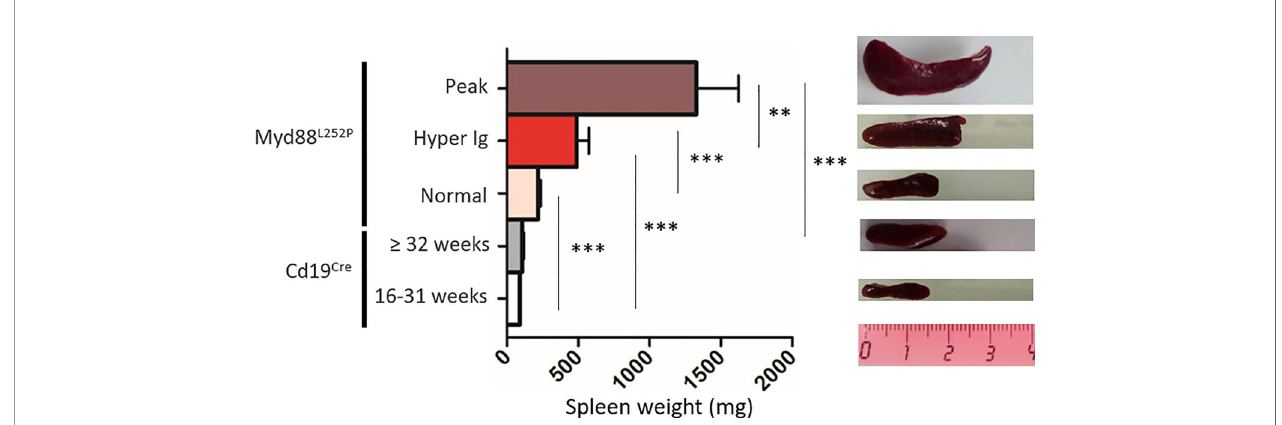
FIGURE 4 | Myd88 L252P mice exhibited a progressively increasing splenomegaly consistently related to the SPE pro fi le. Spleen size of Cd19 Cre and Myd88 L252P age-paired mice. Myd88 L252P mice were sacri fi ced together with at least one Cd19 Cre mouse of the same age. Left panel: distribution of spleen weights; right panel: examples of spleen macroscopy (Cd19 Cre n = 9 for 16-31 weeks-old and n = 16 for ≥ 32 weeks; Myd88 L252P with normal SPE: n = 9; with hyper Ig: n = 13; with Ig peak: n = 19). Results are given as the mean ± SEM. Mann Whitney test p-value < 0.01 and p-value < 0.001 are symbolized by ** and ***